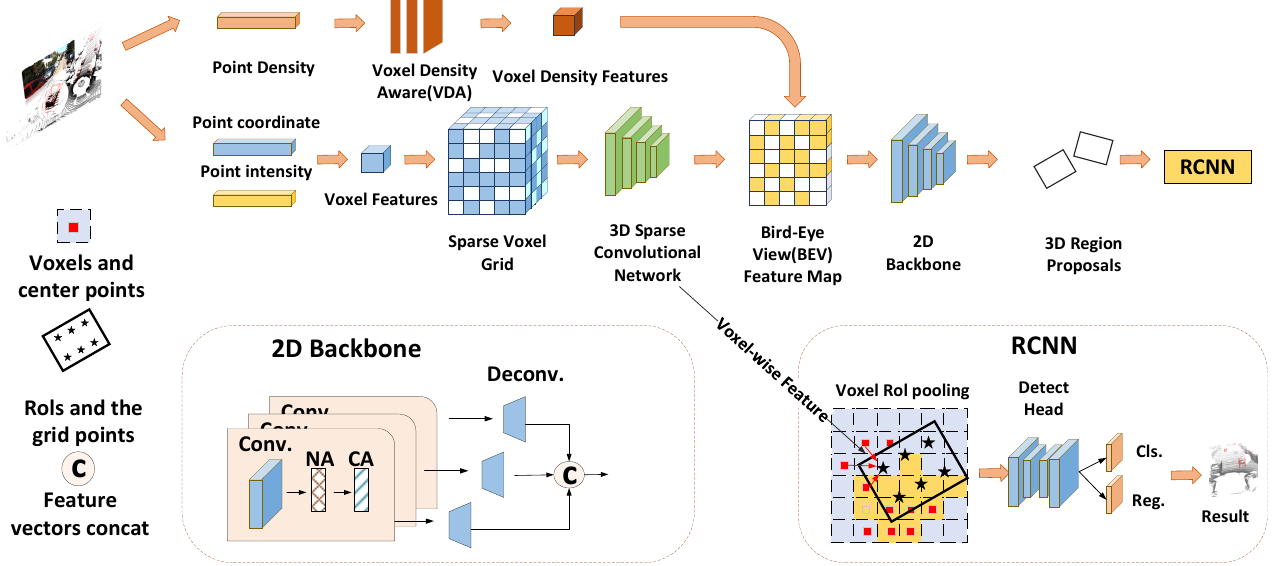
Figure 3. Illustration of the entire DenNet framework. This framework is based on the original Voxel R-CNN. First, we design the voxel density-aware (VDA) module, which can extract density features. Second, the 2D backbone is optimized by adding the NA and CA modules; the original structure is subdivided into three stages such that additional contextual information can be extracted.